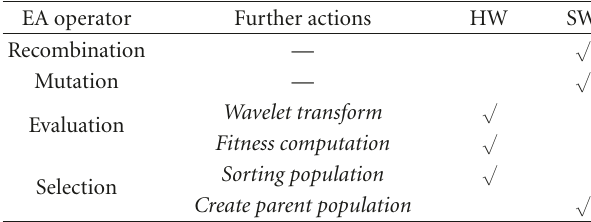
Figure 14: Performance of the best evolved individual for fixed point arithmetic and uniform mutation ( comma selection) against the whole test set: (a) comparison with D9/7 and (b) comparison with D5/3 wavelets. Table 14: HW/SW partitioning of the